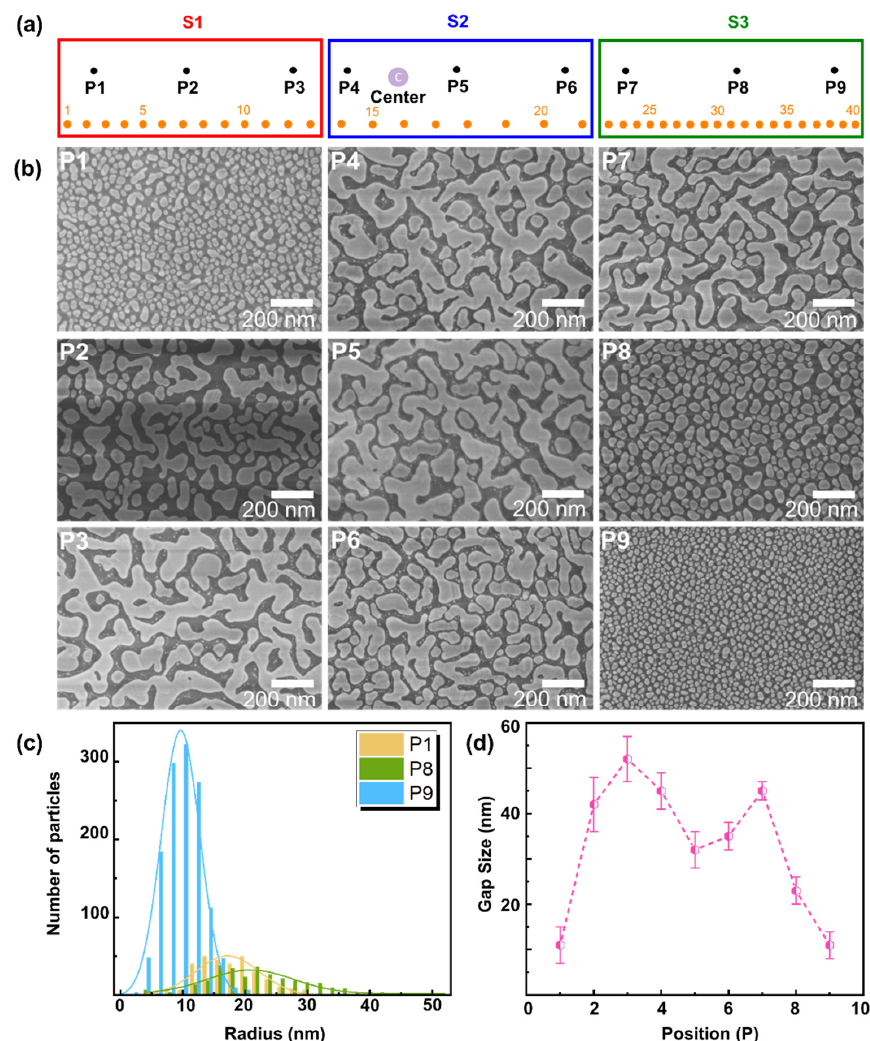
Figure 1. ( a ) Schematic of non-uniform SERS substrates S1, S2, and S3 marked with points P1 to P9 (black, points where SEM images were taken), and with points 1 to 40 (orange, points where extinction spectra were acquired); the length of each substrate is 40 mm. ( b ) SEM images (P1 to P9) at corresponding points marked in ( a ). ( c ) Au particle size distribution at points P1, P8, and P9, and ( d ) average size of gaps between Au NPs/islands at points P1 to P9. Afterwards, SEM images at points P6 and P7 show a slow transition from a connected island-like morphology towards particle-like features. Finally, points P8 and P9 of S3 are further away from the center and are covered by relatively spherical particles. Figure 1c shows the particle size distributions at points P1, P8, and P9, as determined with the image processing software ImageJ. At P1, the average particle size (radius) is 15 ± 10 nm, and moving across the island film to P8 leads to larger particles with 20 ± 13 nm. The largest particle density with the smallest particles is observed at P9, with an average particle size of 10 ± 6 nm. The average particle sizes at points P2 to P7 cannot be easily determined since the substrate is covered with connected Au islands. An important parameter for SERS enhancement is the gap between the particles/islands. Figure 1d shows the average gap size between Au NPs and Au islands at points P1 to P9. The gap sizes were evaluated in the image processing software Gwydion. At point P1, the average gap size between the Au NPs is 11 ± 4 nm. As can be seen in the SEM images, at P2, the surface morphology changes from NPs to an island film, which leads to an increase in the gap size to 42 ± 6 nm